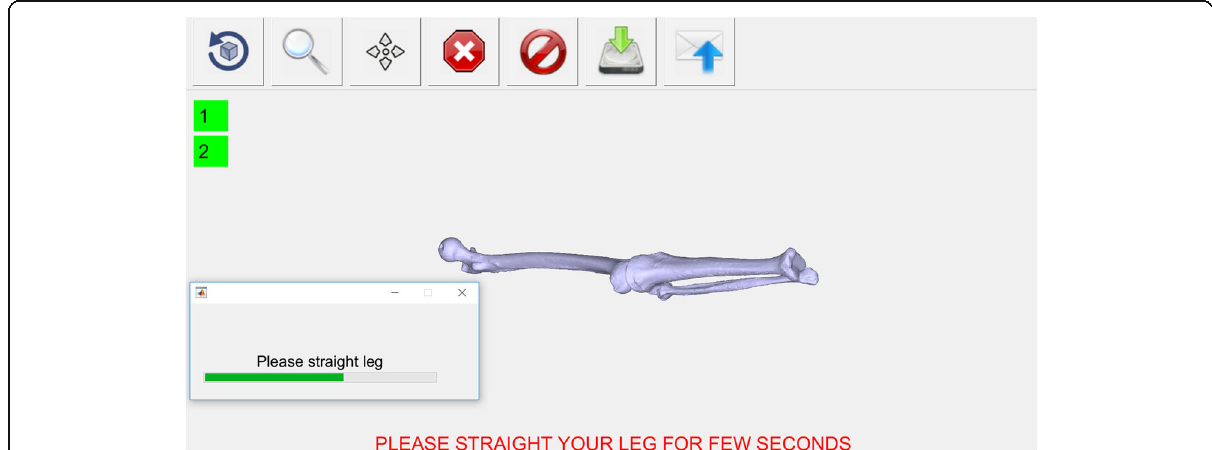
Fig. 4 Measuring the straight leg position with the implemented medical